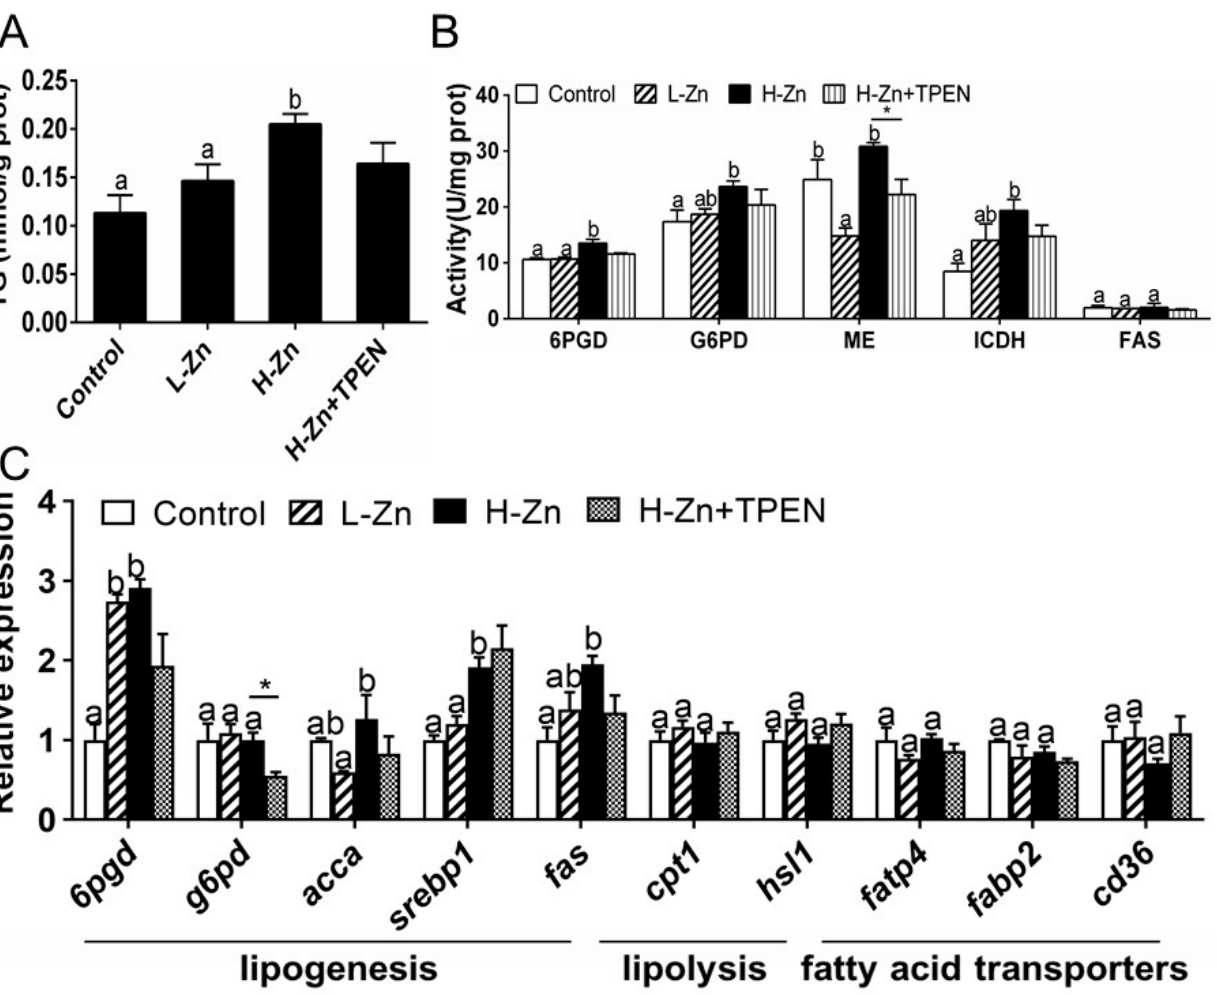
Figure 3. Triglyceride (TG), enzyme activities, and gene expression of the intestinal tissues of yellow catfish fed four experimental diets. ( A ) TG content. ( B ) Enzyme activities. ( C ) The mRNA expression of lipid metabolism-related genes. L-Zn: low dietary Zn; H-Zn: high dietary Zn; H-Zn + TPEN: high dietary Zn + TPEN. Different letters indicate significant differences among three dietary Zn levels ( p < 0.05 ). Asterisks (*) indicate significant differences between the 100 mg/kg nano-ZnO group and the 100 mg/kg nano-ZnO + TPEN group ( p < 0.05). For each value, three biological replicates are undertaken.